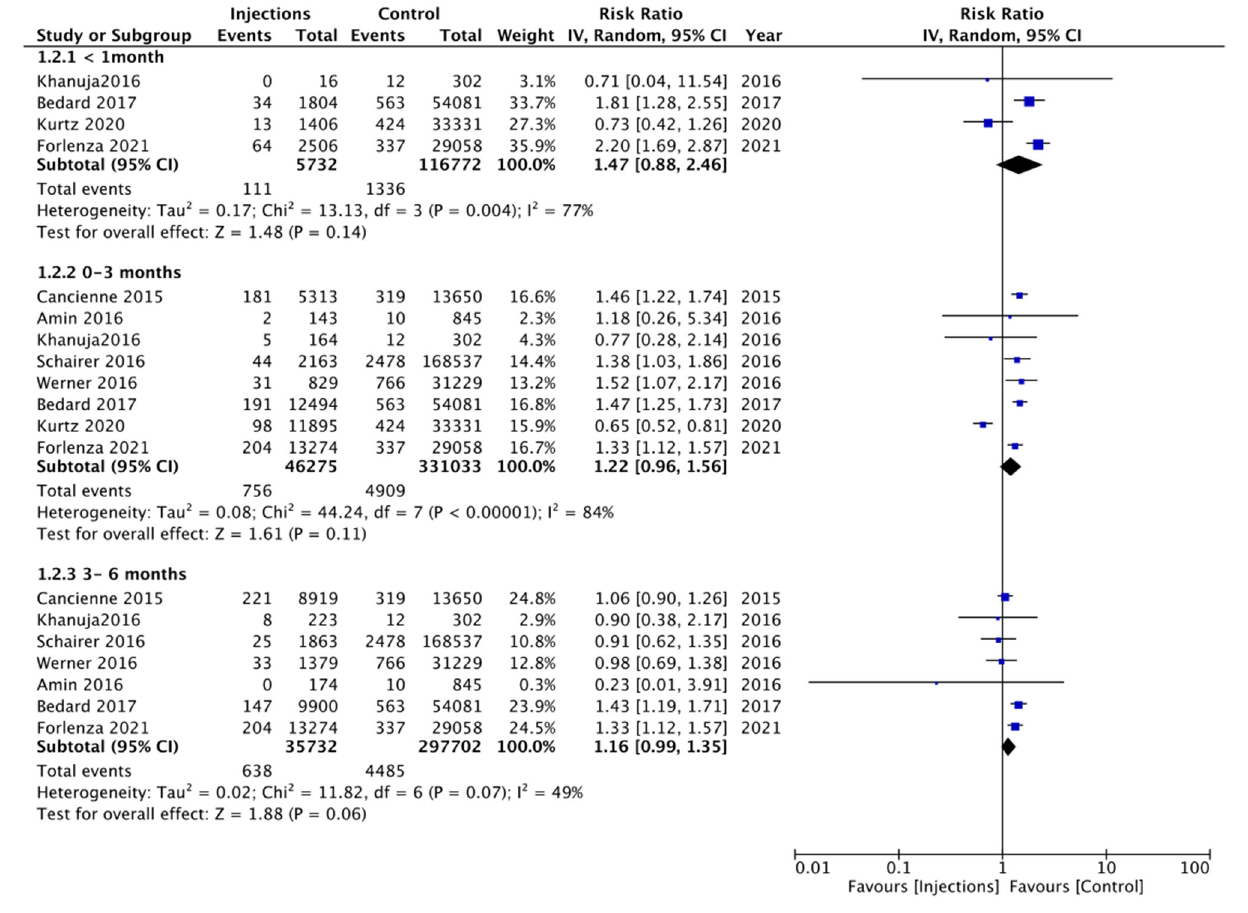
FIGURE 3 | Meta-analysis of PJI between injection and control groups with sub-group analysis based on timing of injection before surgery as < 1 months, 0–3 months, and 3–6